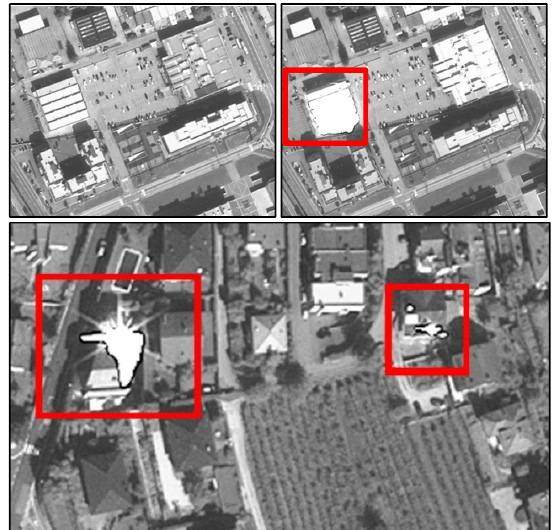
Figure 3. Examples of artefacts found in GE1 images.